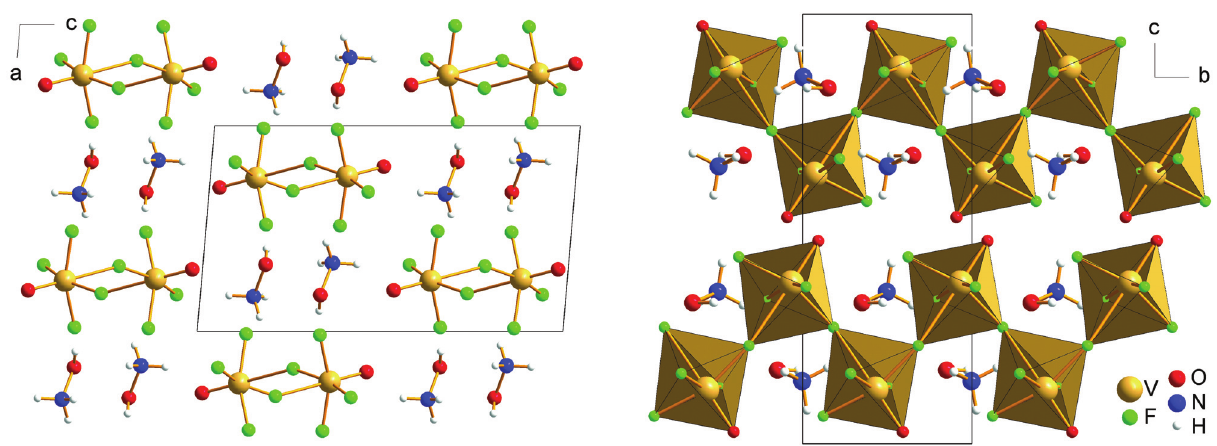
] viewed along b - and a -crystallographic axes, respectively. Note the resemblance of [ VOF OH) [ VOF 3 4 ] and Ag [ VOF ] . OH) [ VOF 3 4 4